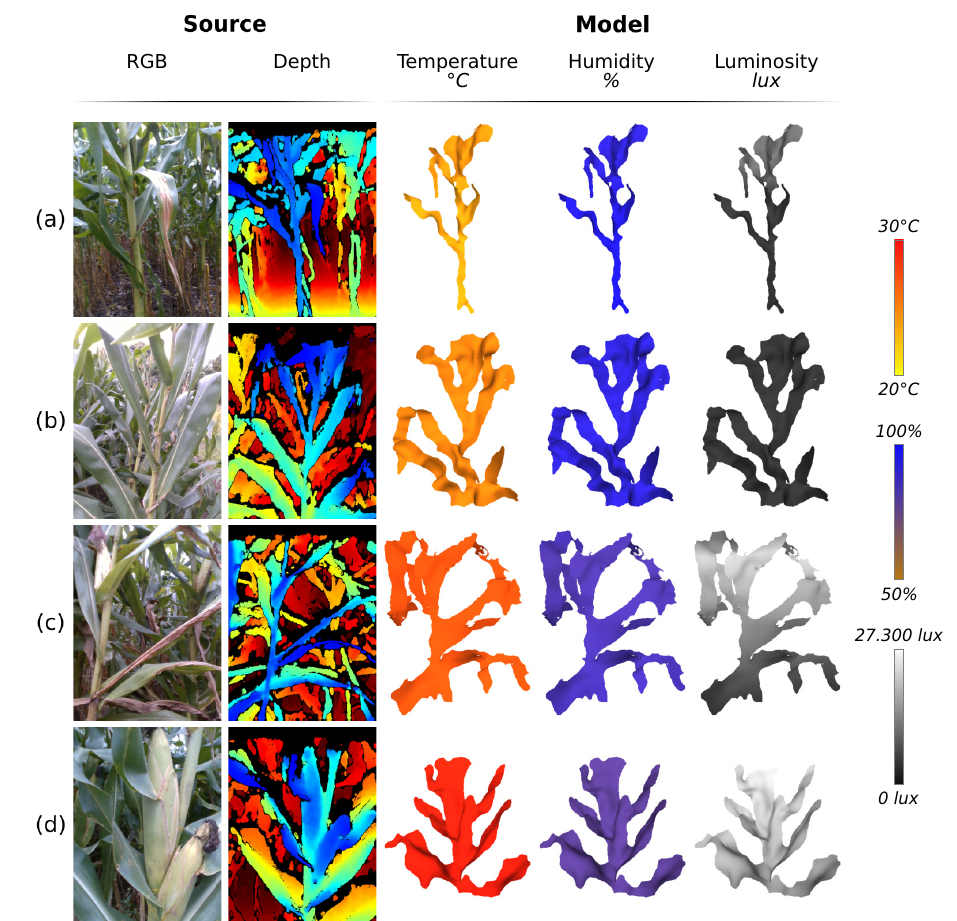
Figure 18. Generated models and fusion with sensor data. ( a ) Plant inside the row with low light incidence (cloudy); ( b ) plant outside the row with low light incidence; ( c ) plant inside the row with high light incidence (sunny); and ( d ) plant outside the row with high light